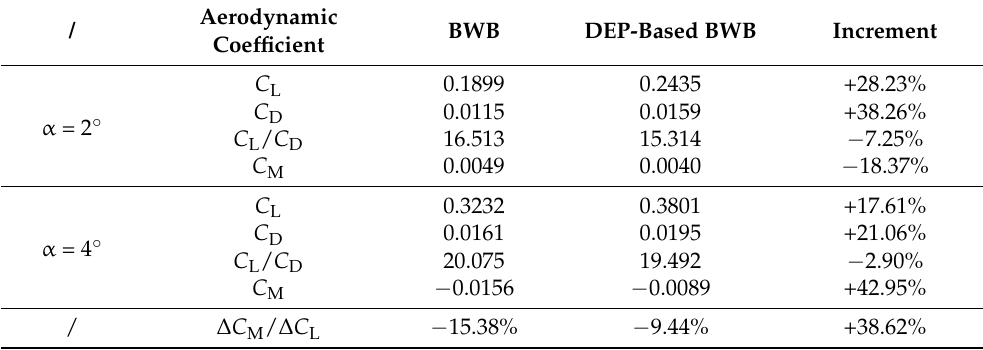
Table 5 . Results of grid independence test for the present BWB configuration. Table 5. Results of grid independence test for the present BWB configuration.